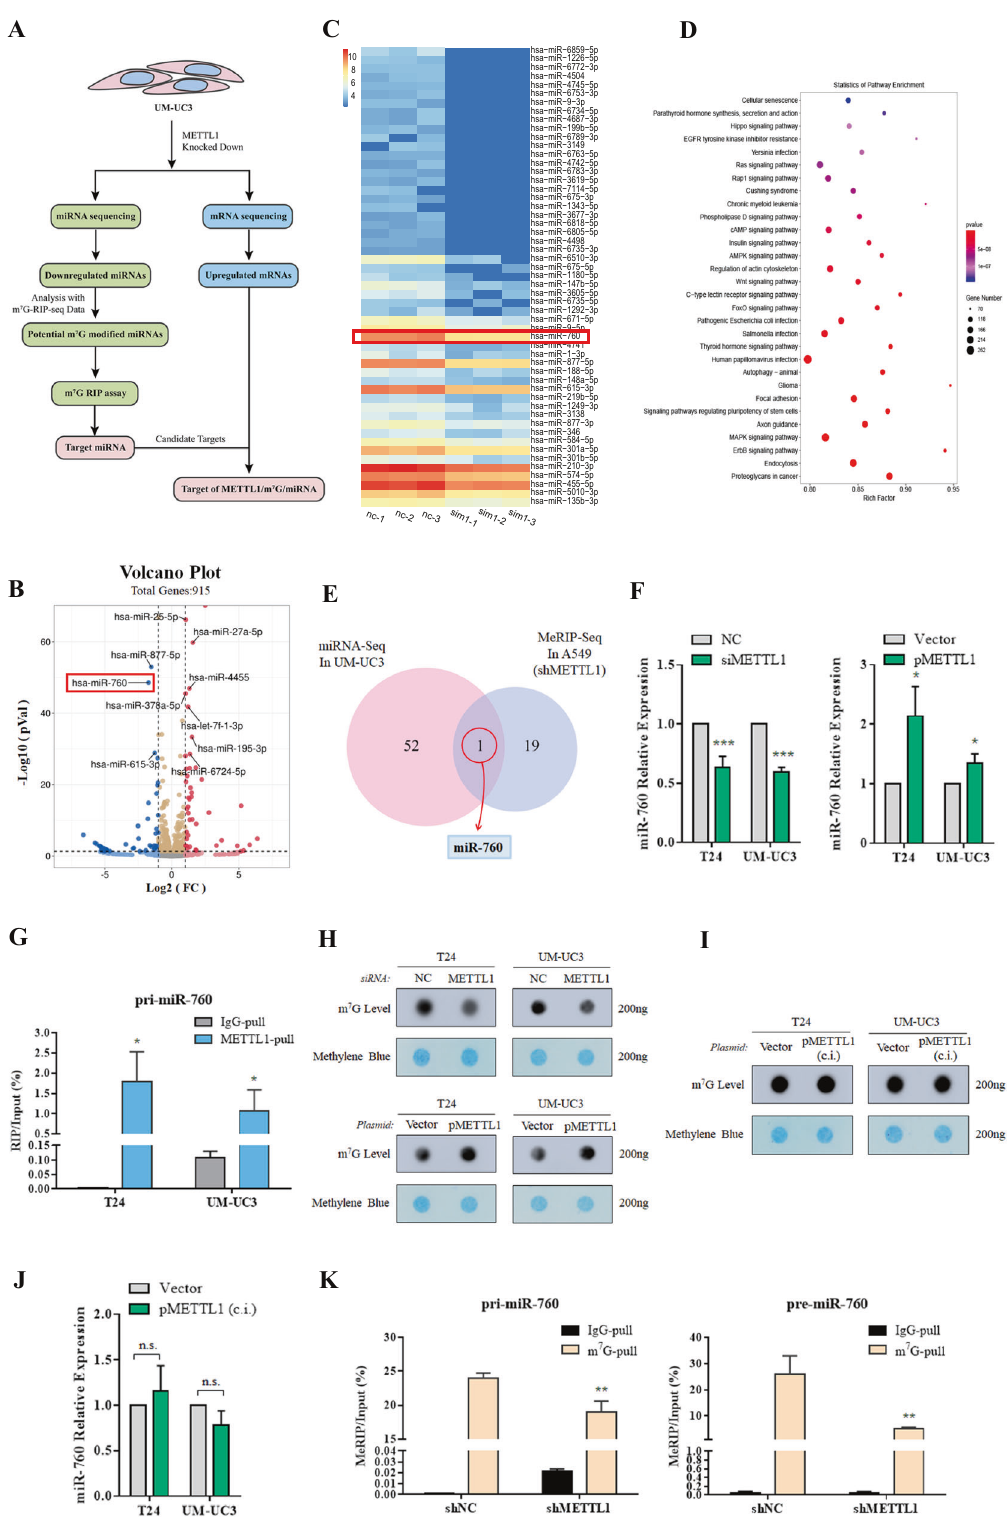
RNA m 7 G modi fi cation induced by dysregulation of METTL1 or WDR4 played an important role in tumorigenesis [36]. Upregu- lated METTL1 and WDR4 promoted the translation of oncogenic transcripts depending on m 7 G-modi fi ed tRNA to promote intrahepatic cholangiocarcinoma progression [23]. And m 7 G tRNA